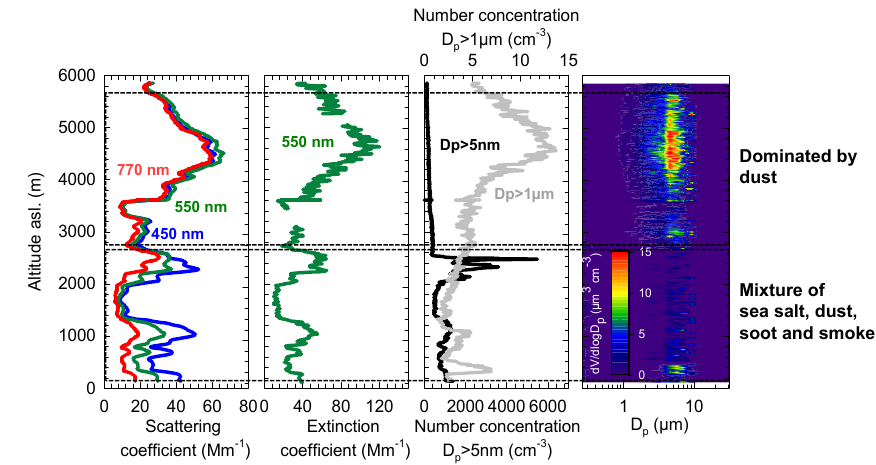
Figure 21. Optical (scattering and extinction coefficients) and physical (number concentration and volume size distribution) aerosol proper- ties estimated along the vertical onboard the ATR-42 aircraft for the flights 35–36 on 22 June over the Lampedusa station.